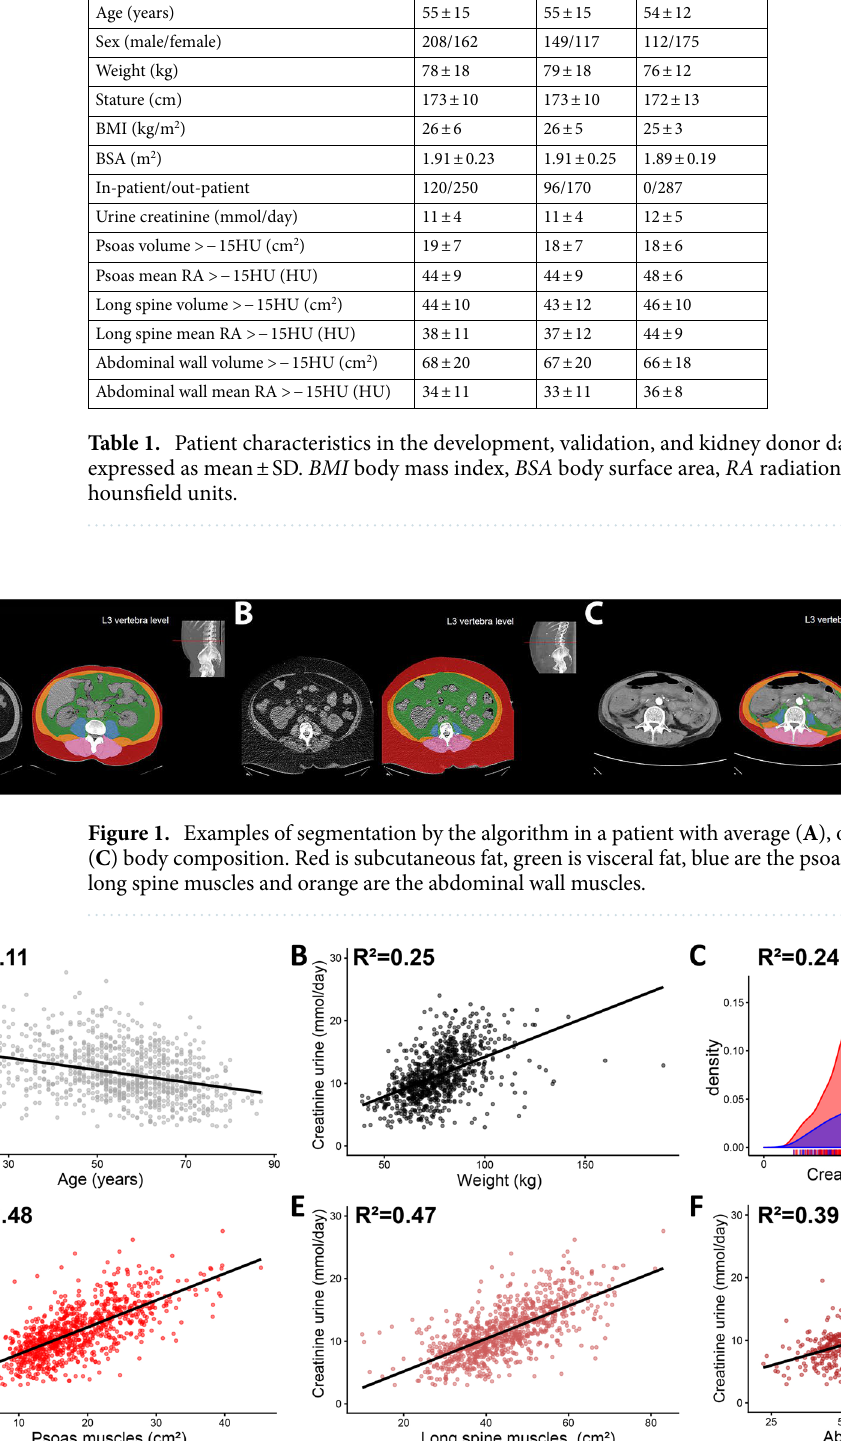
Figure 2. Plots comparing muscle surface areas and clinical parameters with urinary creatinine excretion. ( A – C ) Association with clinical characteristics age ( A ), weight ( B ), and Sex ( C ). ( D – F ) Association between muscle surface areas (segmented > − 15HU) from the psoas muscles ( D ), long spine muscles ( E ), and abdominal wall muscles ( F ). Solid regression lines in dot plots are calculated with ordinary least squares regression. The probability density was calculated with kernel density estimation and shows excretion in the female (F, red colour) and male sex (M, blue colour). The dashed line represents the mean of the different groups. The R 2 - values were calculated with ordinary least squares